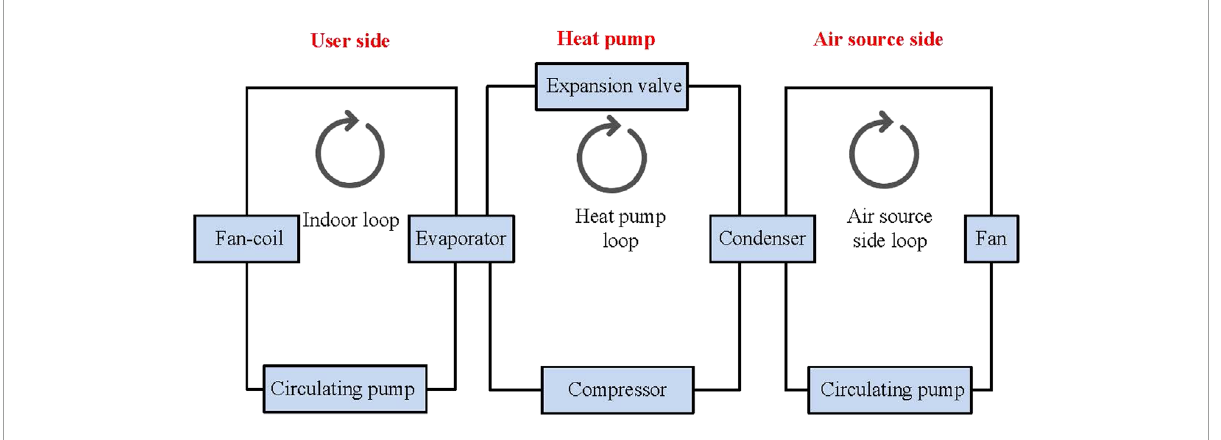
FIGURE 1 Diagram of the ASHPAC system.